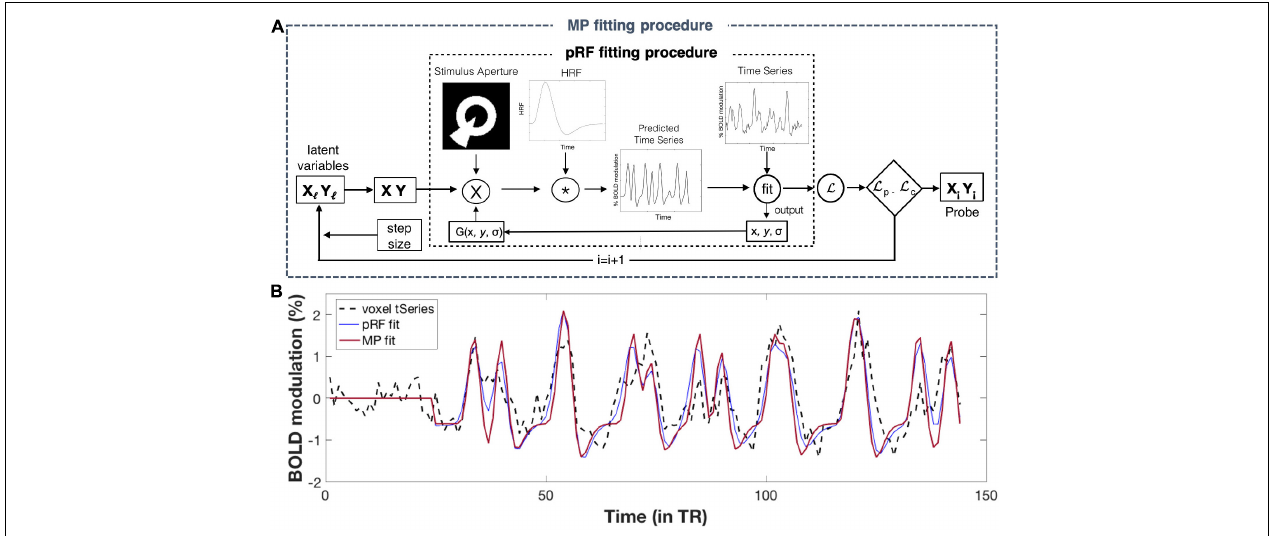
FIGURE 2 | Population receptive field (pRF) and MP fitting: (A) Flowchart of fitting procedures. Conventional pRF fitting procedure : First, a two-dimensional Gaussian pRF is defined using three parameters: x and y (for its center location), and σ (for its width). The pRF response is predicted by calculating the overlap between the pRF (2D Gaussian) and the stimulus aperture. Next, this predicted response is convolved with an HRF function in order to obtain a time-series prediction for a particular voxel. For all possible pRFs, these predicted time-series are iteratively tested to fit a voxel its actual time-series. The optimal pRF properties correspond to ones that result in the best pRF fit (i.e., the one with the highest variance explained) per voxel. For a more detailed explanation of this fitting procedure, see Dumoulin and Wandell (2008). MP fitting procedure : The MP fitting procedure is based on the conventional pRF fitting procedure. Here, a Bayesian Markov Chain Monte Carlo (MCMC) sampling approach was used to fit a 2D Gaussian probe to voxels time-series. With this approach, the probe’s center location (x, y) is based on two latent variables and the width ( σ ) is small and fixed (here we used σ = 0.01 ◦ ). Like the pRF procedure, a voxel’s predicted response was calculated and convolved with an HRF function before fitting it to the voxel’s actual response. The fit is done using likelihood, which allows the update of the latent variables (x, y), for the next iteration. The MCMC sampling approach therefore allowed for an efficient sampling of the VF, where the regions in visual space with better fits are more highly sampled. To this end, MP provides a single probe map per voxel, consisting of many probe locations with their corresponding variance explained, reflecting the sampling density of that particular voxel. For a more detailed explanation of this fitting procedure, see Carvalho et al. (2020) (Figure adapted from Carvalho et al. (2020); used with permission). (B) Example fits for a single voxel. Simulations of pRF- and MP fit to the actual time-series of a single voxel, using the pRF parameters of the conventional pRF and the MP best fit. The flat line at the start corresponds to the blank period. For more details on how to extract the pRF parameters for MP,